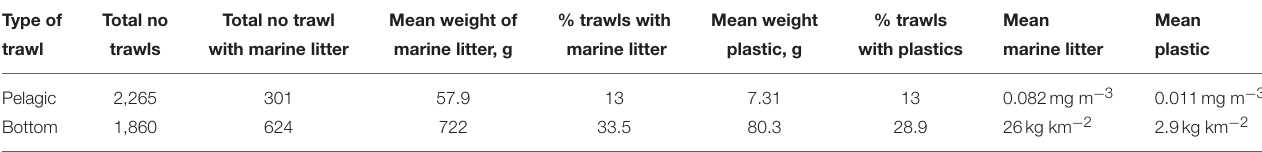
TABLE 4 | Marine litter observations, frequencies, and mean amount in the Barents Sea. Type of Total no Total no trawl Mean weight of % trawls with Mean weight % trawls Mean Mean trawl trawls with marine litter marine litter, g marine litter plastic, g with plastics Pelagic 2,265